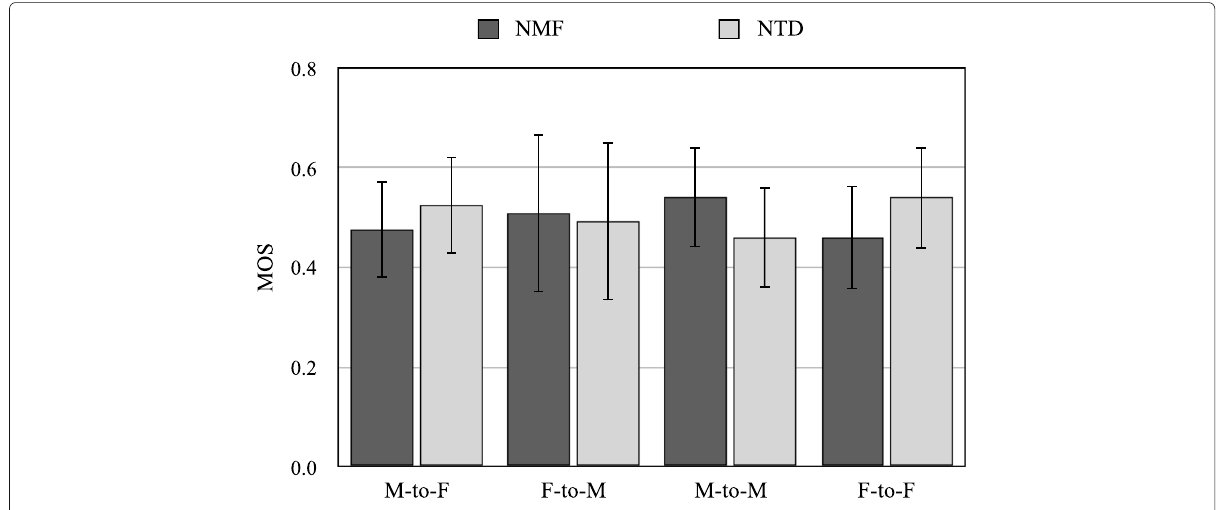
Fig. 7 XAB test between NMF and NTD